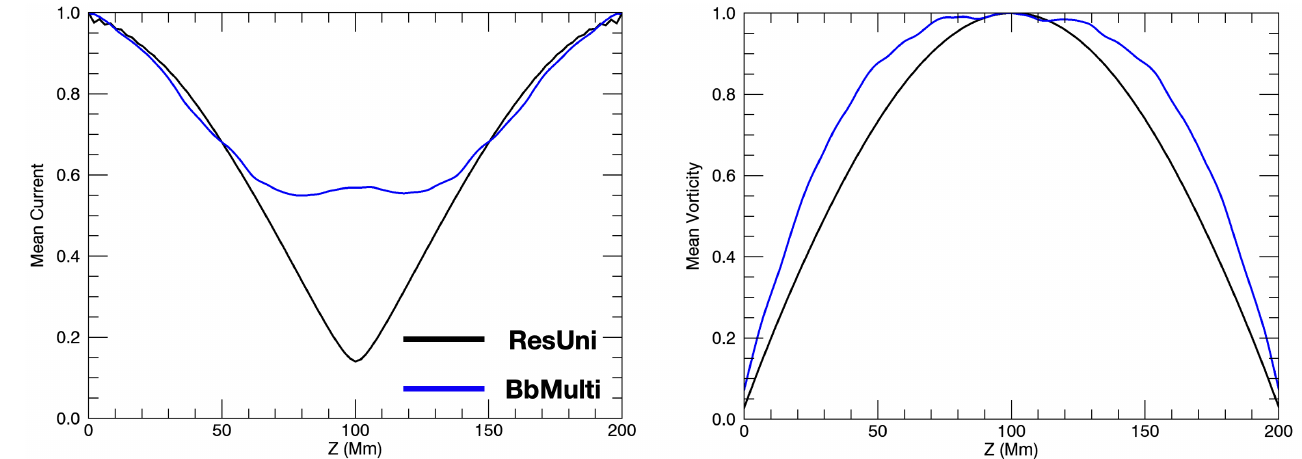
Figure 8. Mean current density ( left ) and vorticity ( right ) as a function of z for the ResUni (black curves) and BbMulti (blue curves) simulations. The mean is calculated over all x and y (at a particular value of z ) over the duration of the simulations. Each curve is normalised to ts maximum. See text for